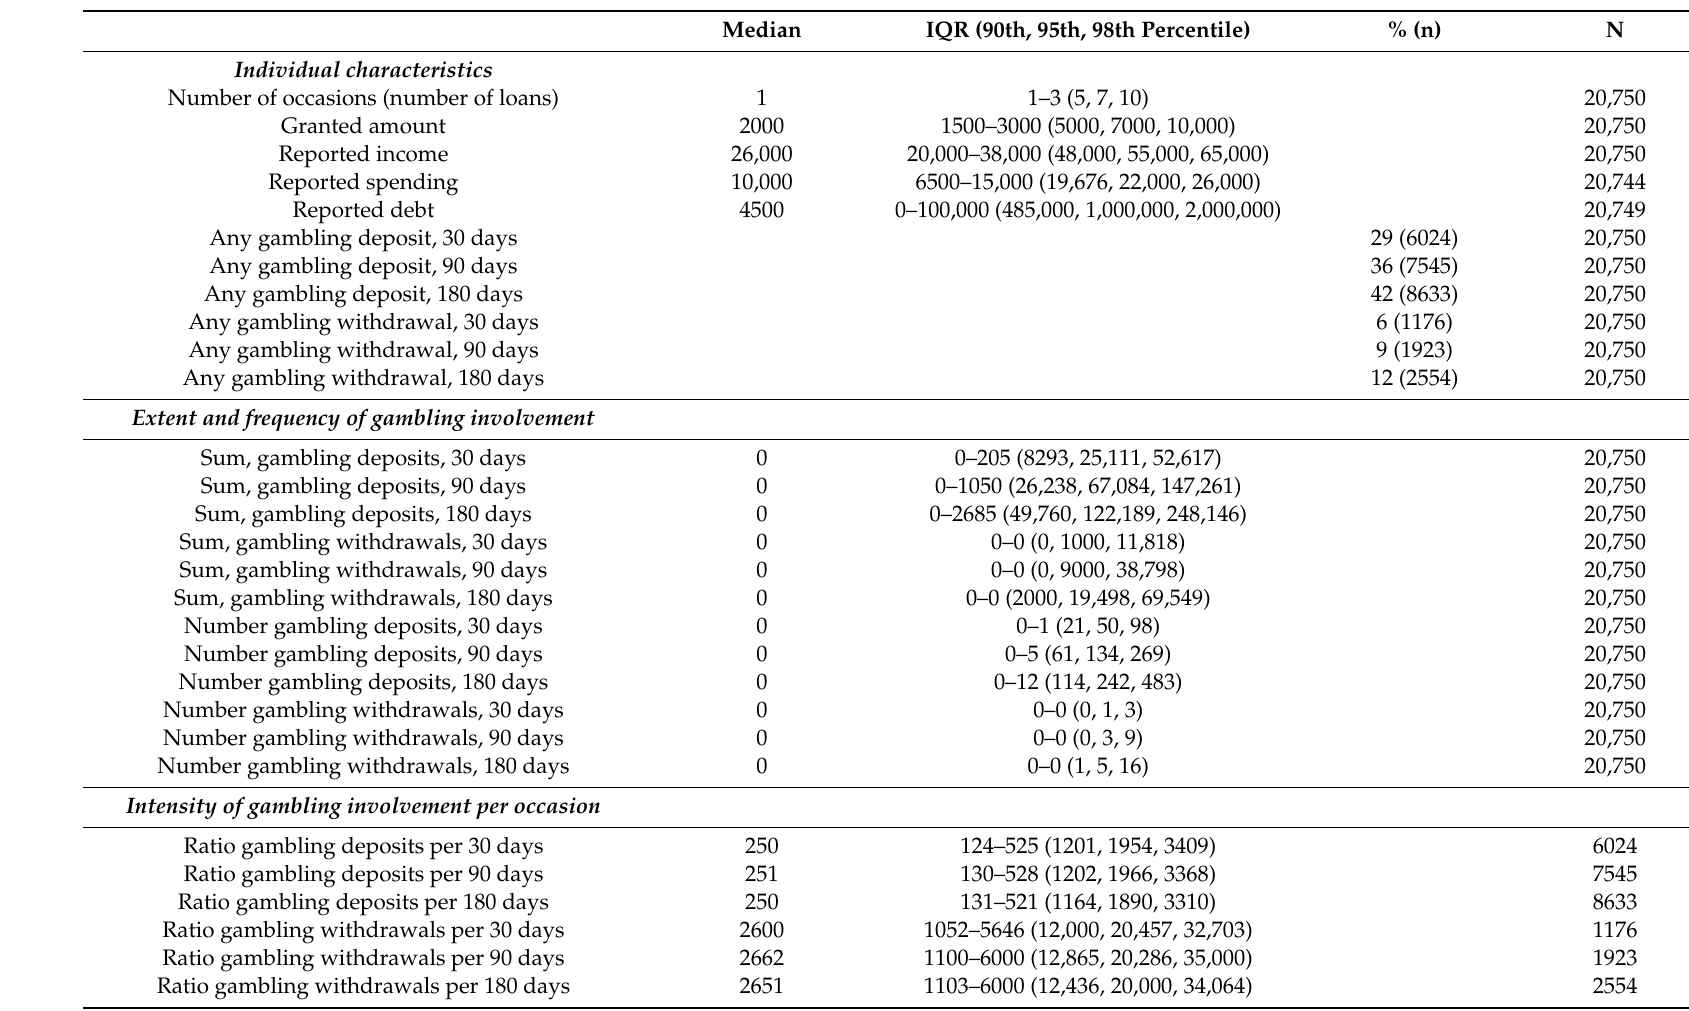
Table 1. Characteristics of included subjects (N = 20,750). Baseline data of primary loan